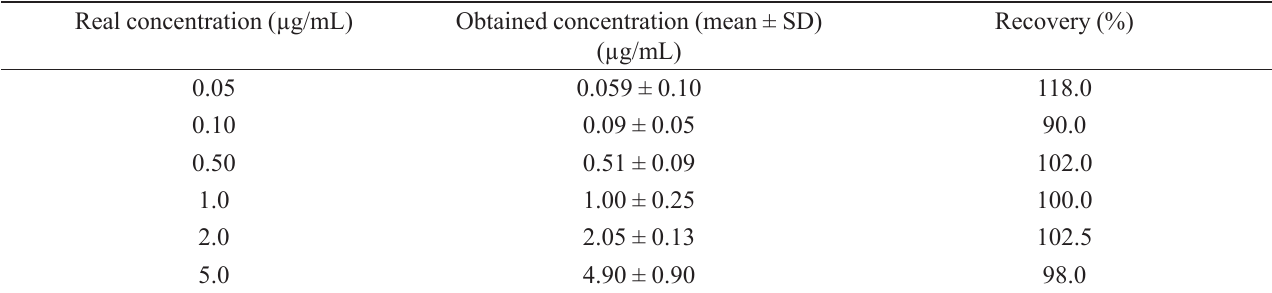
TABLE IV - Recovery of quercetin after the drying procedure of the extractor solvent Real concentration